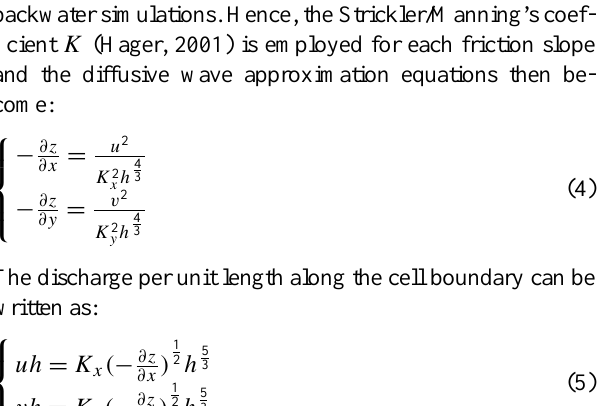
Fig. 3. Demonstration of flow on a square grid system in MIKE SHE model; source: DHI